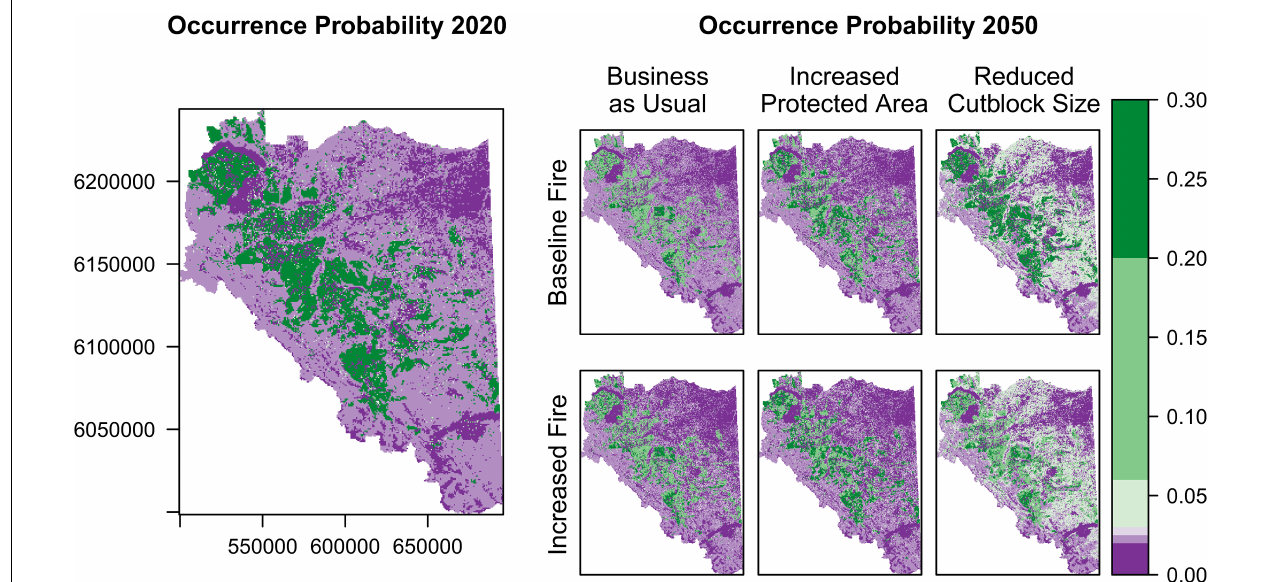
FIGURE 3 | Occurrence probability of olive-sided flycatchers across the southern Peace River region of British Columbia, based on habitat suitability indices derived from parameter estimates of top-ranked habitat suitability models C08 and U05 ( Table 2 ). Values closer to 1.0 (green) indicate the most suitable habitat and values closer to 0 (purple) indicate the least suitable habitat. The 2020 map shows probability of olive-sided flycatcher occurrence under current conditions, including recent mountain pine beetle outbreaks. The 2050 maps show future expected probability of olive-sided flycatcher occurrence, given projected forest harvesting, wildfires, urbanization, and agricultural expansion, under six scenarios that combined three management alternatives with two wildfire alternatives. Management alternatives were: Business As Usual, Increased Protected Area (protected areas increased from 13% to 30% of land base), and Reduced Cutblock Size (size of clearcuts limited to 10 ha). Wildfire alternatives were: Baseline Fire (fire frequency maintained at historic levels) and Increased Fire (50% increase over historic levels). Results are limited to three million ha for which data were available. The Rocky Mountains run northwest to southeast across the study area.